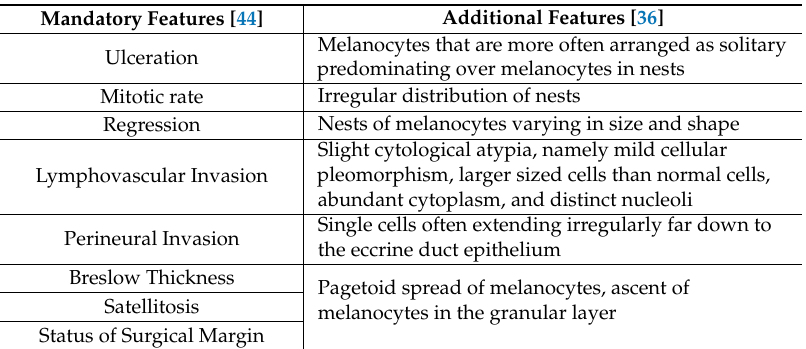
Table 1. List of mandatory and additional histopathologic features to be reported by a